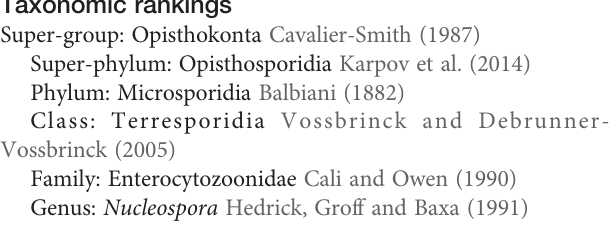
( Figure4E ).Asdevelopmentprogressed,moreelectron-densediscs were synthesized in the early sporogonial plasmodium